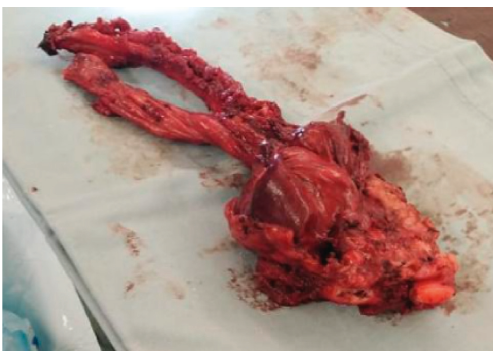
Figure 3: This is the en bloc resected specimen showing the in- volved ribs completely resected (on the left side) with the residual Ewing sarcoma tumorous mass, including the thoracic muscles (on the right side of the picture), resected to secure free margins.